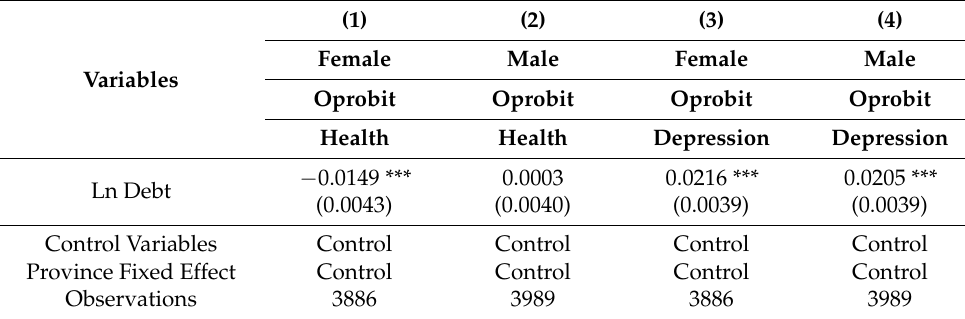
Table 8. Heterogeneity analysis results (gender